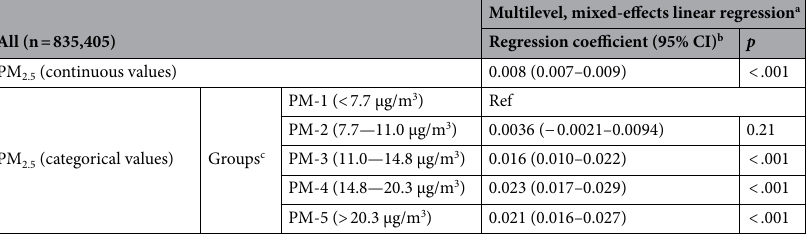
Table 3. Association between PM 2.5 exposure and in-hospital medical expenses (log yen). PM 2.5 , particulate matter with aerodynamic diameters ≤ 2.5 µg/m 3 ; CI, confidence interval. a The mixed model was used to correct for random effects due to interhospital variations. b Regression coefficients were adjusted for temperature, humidity, eastern/western Japan, season, number of hospital beds, age, sex, height, weight, Brinkman index, Charlson comorbidity index, angina pectoris, acute myocardial infarction, heart failure, atrial fibrillation/ flutter, aortic disease, cardiac arrest, pulmonary embolism, pulmonary hypertension, and tetralogy of Fallot. c Classified according to PM 2.5 exposure concentration.